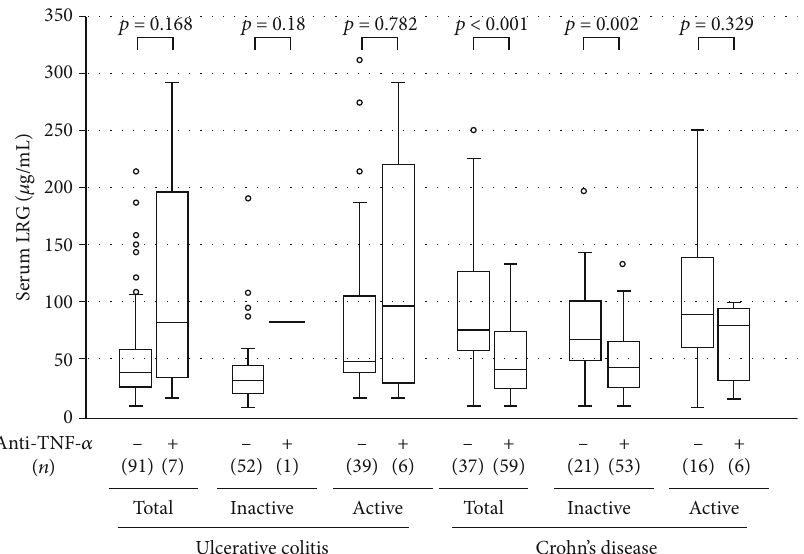
Figure 6: E ff ect of antitumor necrosis factor- (TNF-) α agents on serum leucine-rich alpha-2 glycoprotein (LRG) levels in the patients with ulcerative colitis and those with Crohn ’ s disease. For each disease, patients were divided into two treatment-based subgroups: patients taking anti-TNF- α agents and patients receiving any other medication. The bars indicate the median ± 25 th percentile. The lower bar indicates the 10 th percentile, and the upper bar indicates the 90 th